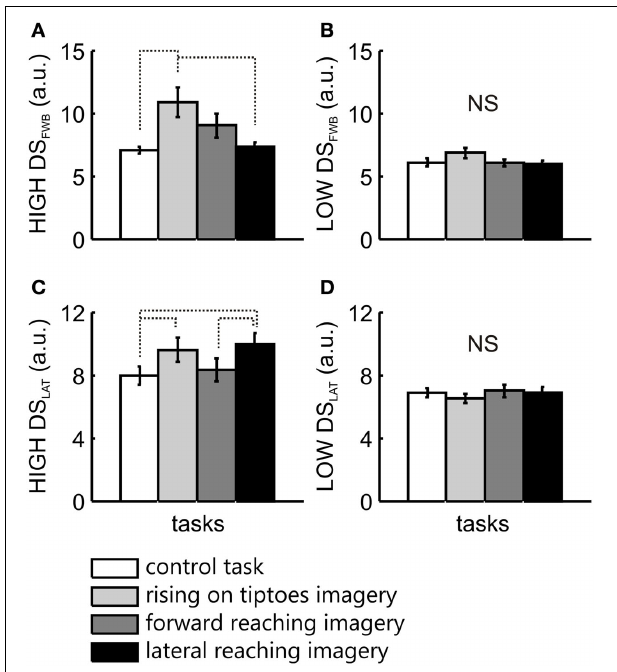
FIGURE 3 | COG variability analysis for the two imagery vividness groups. The mean ± s.e.m. of directional stability in the forward-backward (DS FWB ) and lateral (DS LAT ) directions are presented for the HIGH (A,C) and the LOW (B,D) imagery vividness groups, respectively. Data are shown for control task (white bars), rising on tiptoes imagery (light gray bars), forward reaching imagery (dark gray bars), and lateral reaching imagery (black bars). Significant differences are indicated by dotted lines.